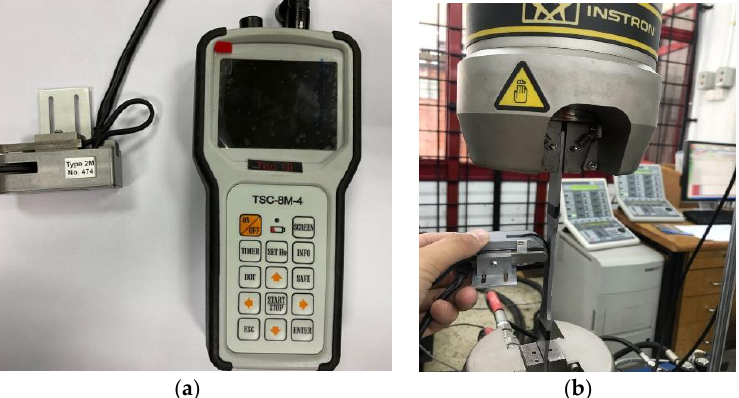
Figure 7. Image of data acquisition for magnetic flux leakage signals; ( a ) Stress concentration testing device for the identification of magnetic flux leakage signals, ( b ) Signal acquisition activity during a cyclic test.